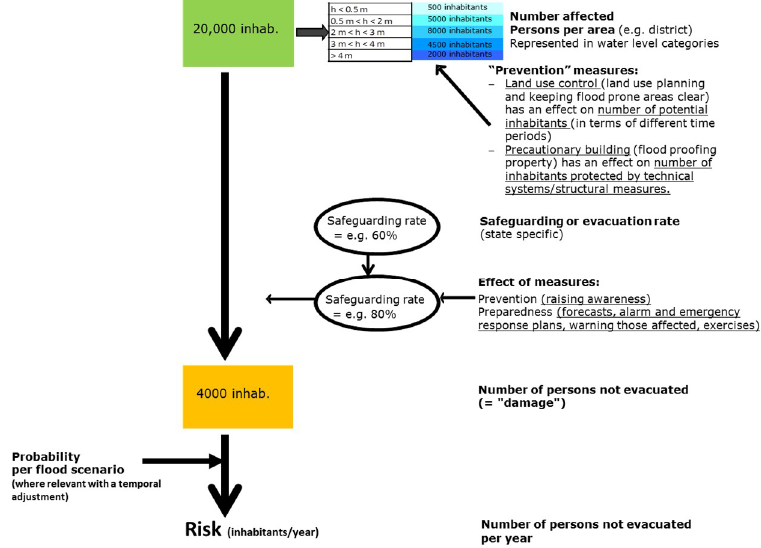
Figure 4. Approach for the analysis of damage to human health [7,8].